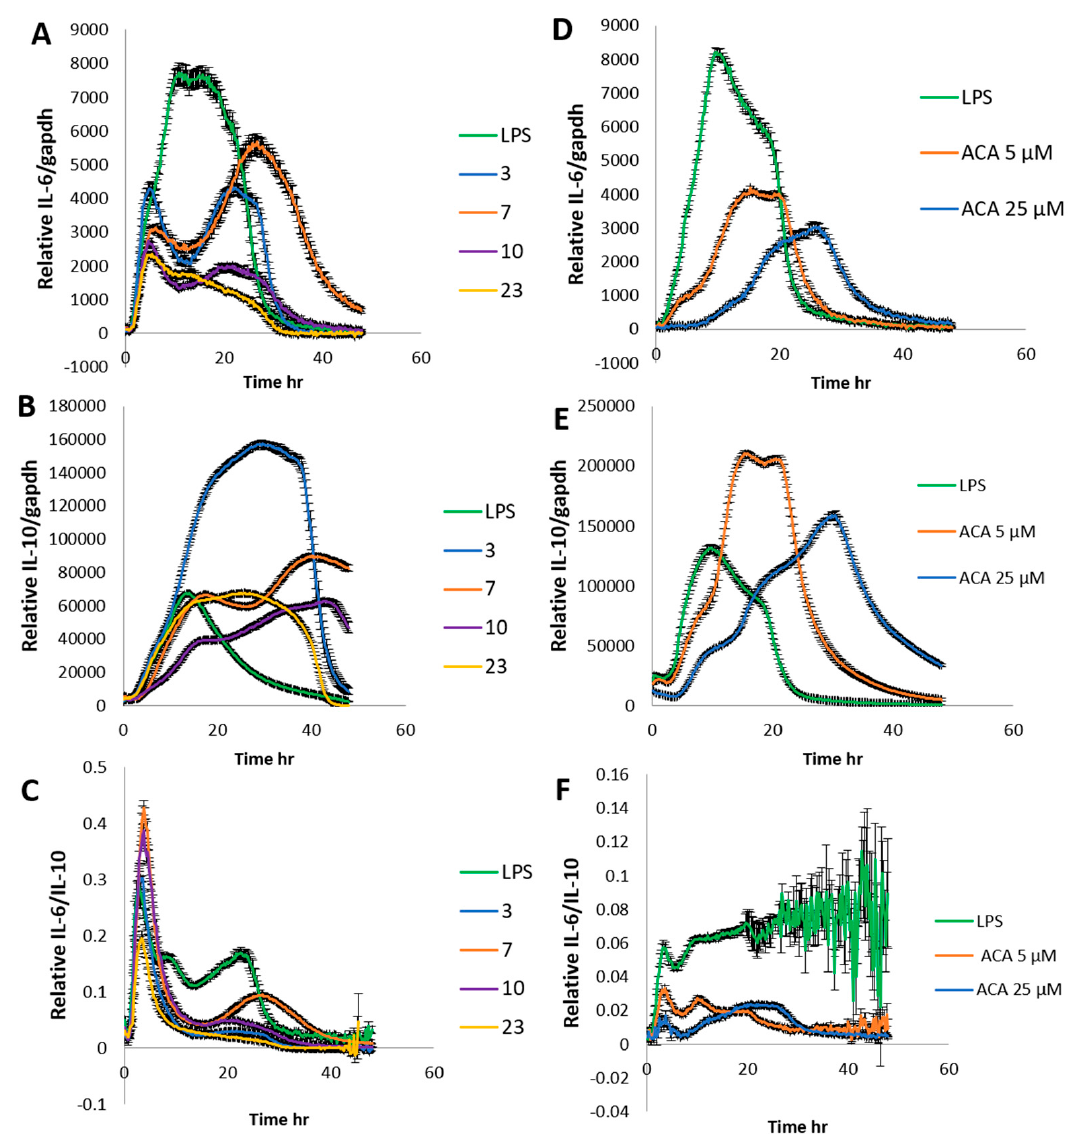
Figure 2. The expression of relative IL-6 / gapdh and IL-10 / gapdh by real-time bioluminescence recording for 48 h. ( A ) Stable IL-6 / gapdh RAW264.7 cells and ( B ) stable IL-10 / gapdh RAW264.7 cells were treated with crude ethanol extracts from nutmeg (3), oregano (7), laurel (10), and long pepper (23) at 75 µ g / mL and LPS at 100 ng / mL. ( D ) Stable IL-6 / gapdh RAW264.7 cells and ( E ) Stable IL-10 / gapdh RAW264.7 cells were treated with 1 (cid:48) S-1 (cid:48) -Acetoxychavicol acetate (ACA) at 5, 25 and 100 µ M from greater galangal and LPS at 100 ng / mL. ( C , F ) Relative IL-6 / IL-10. Each value represents the mean ± SD ( n =